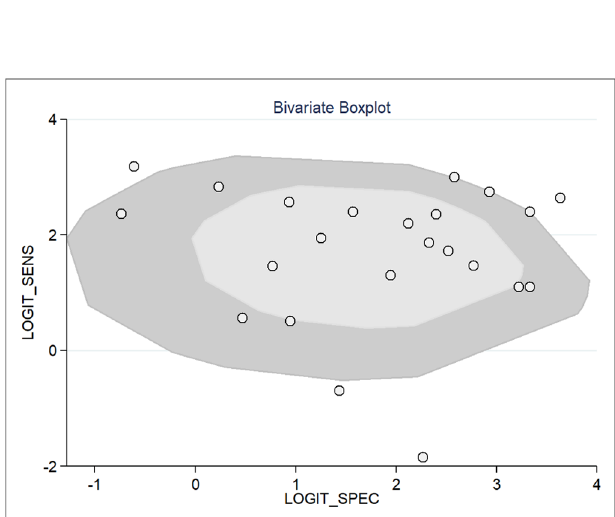
FIGURE 7 | Bivariate boxplot showing sensitivity and speci fi city for included